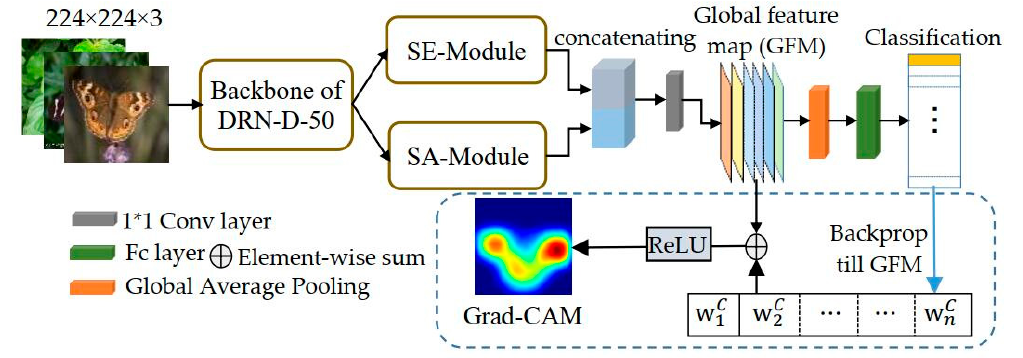
Figure 5. Overall SESADRN architecture.